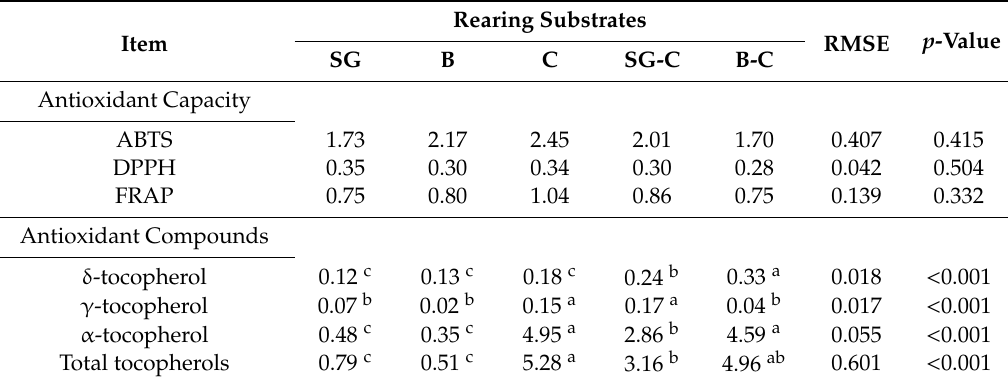
Table 4. Antioxidant capacity (ABTS, DPPH, and FRAP) and antioxidant compounds (tocopherols) of Tenebrio molitor larvae reared on di ff erent